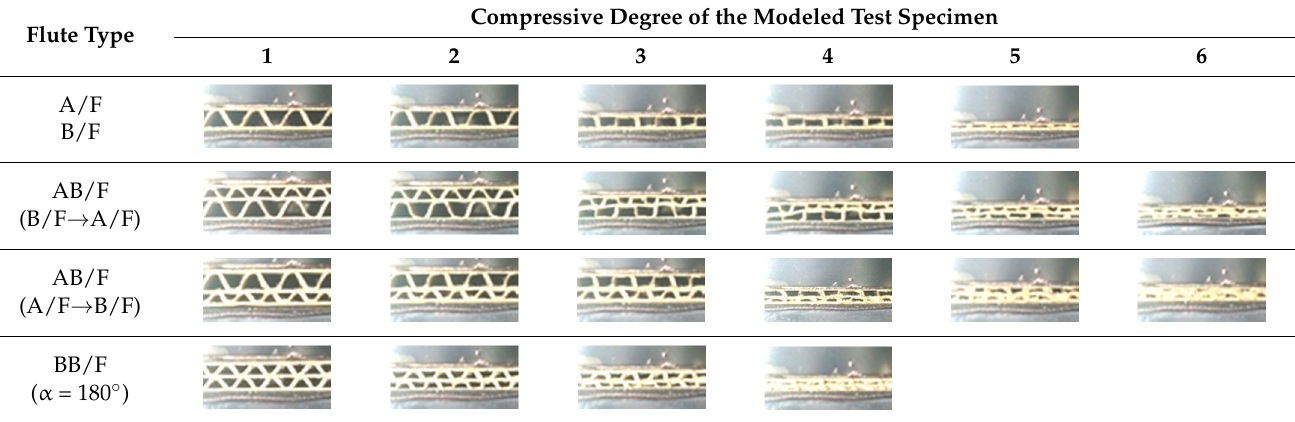
Table 5. Flat crush process of modelled test specimen by flute type through experiment.